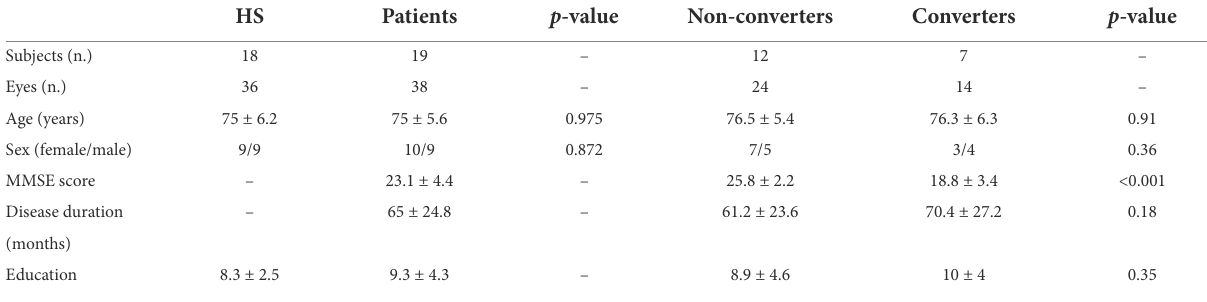
TABLE 1 Demographic and clinical characteristics of cognitive healthy subjects, all patients, non-converters and converters to dementia after 2 years follow-up. HS Subjects (n.)